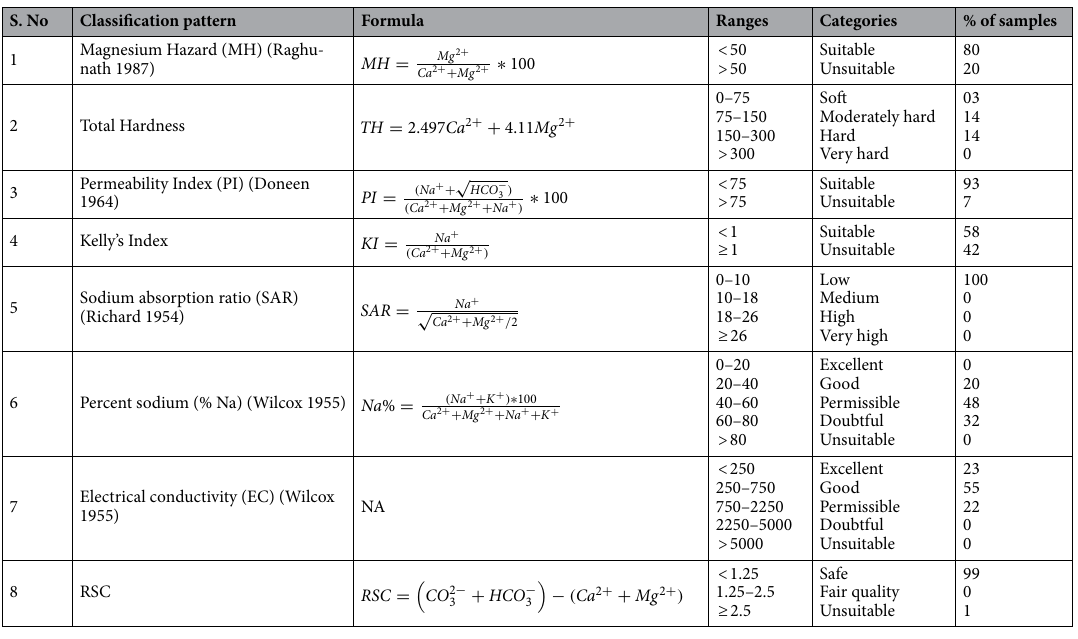
Table 8. Irrigation water classification